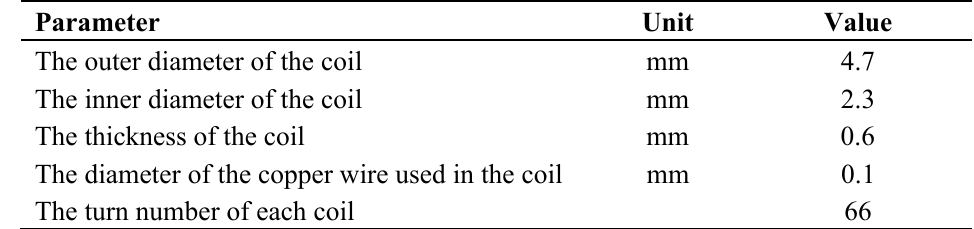
Table 1. The parameters of the coil used in the single-coil probe and the dual-coil probe.